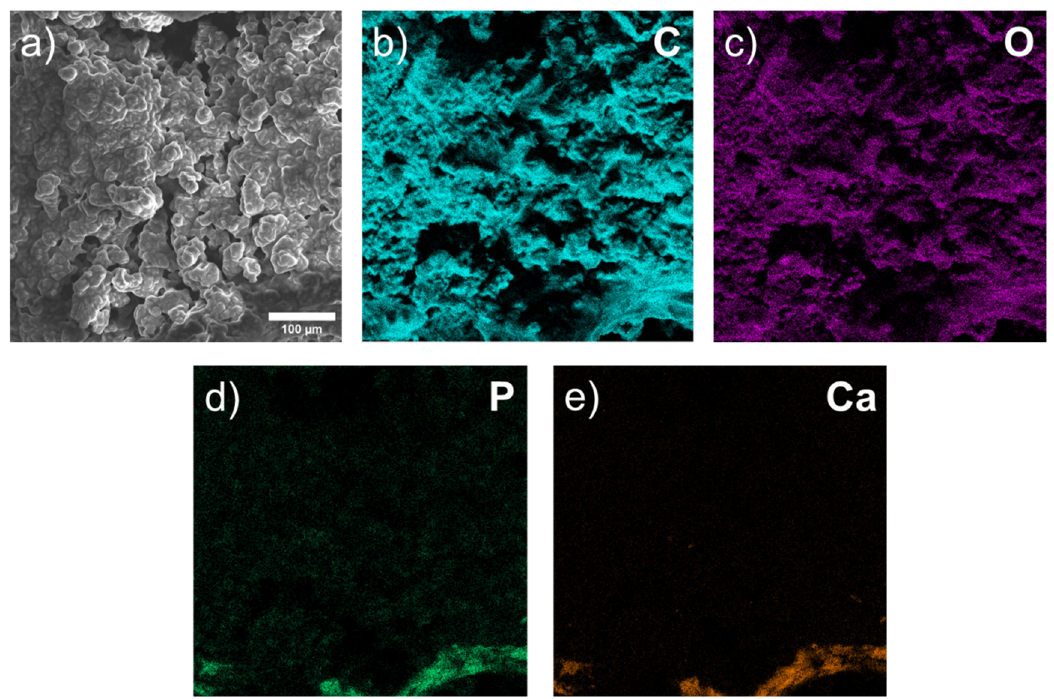
Figure 11. Layered image of EDX sample after 6 months: ( a ) SEM image of bone surface; ( b – e ) elemental maps. Table 3. Total spectrum of map and distribution of elements after 6 months.